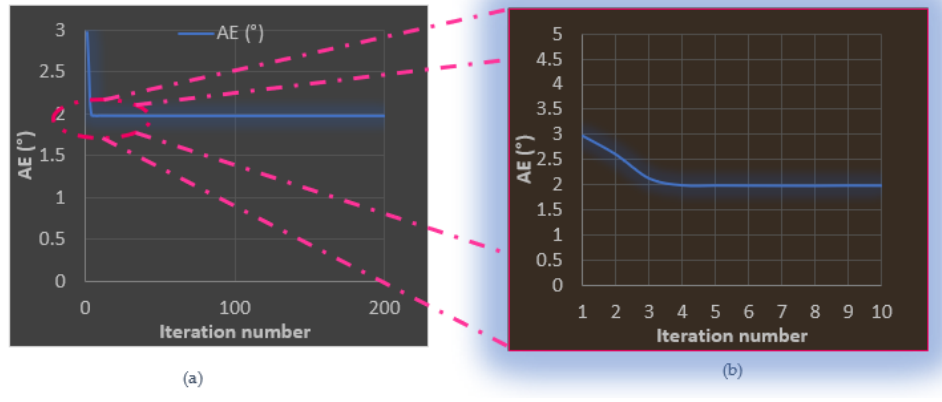
Figure 8. AE related to iteration number .